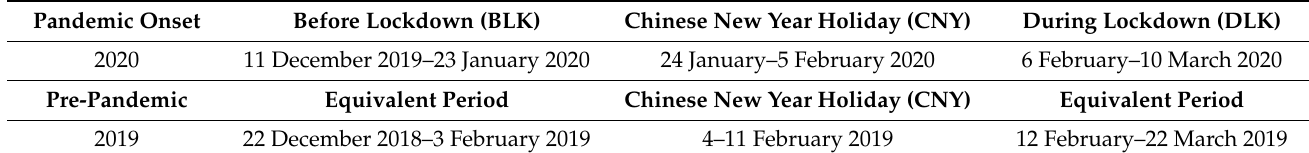
Table 1. Division of the 91-day study timeframe in early 2020 into three consecutive periods of investigation, and the corresponding reference periods in 2019 for